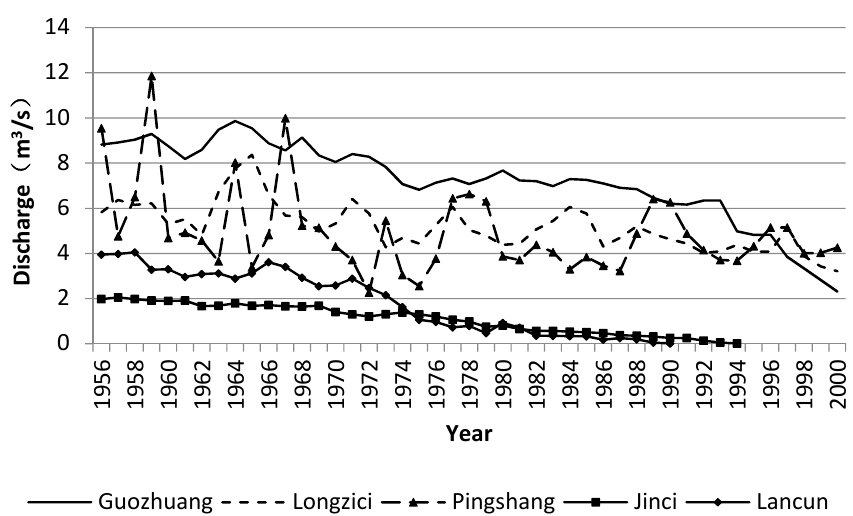
Figure 8. Changes in the flow of typical springs in the Fenhe River basin.